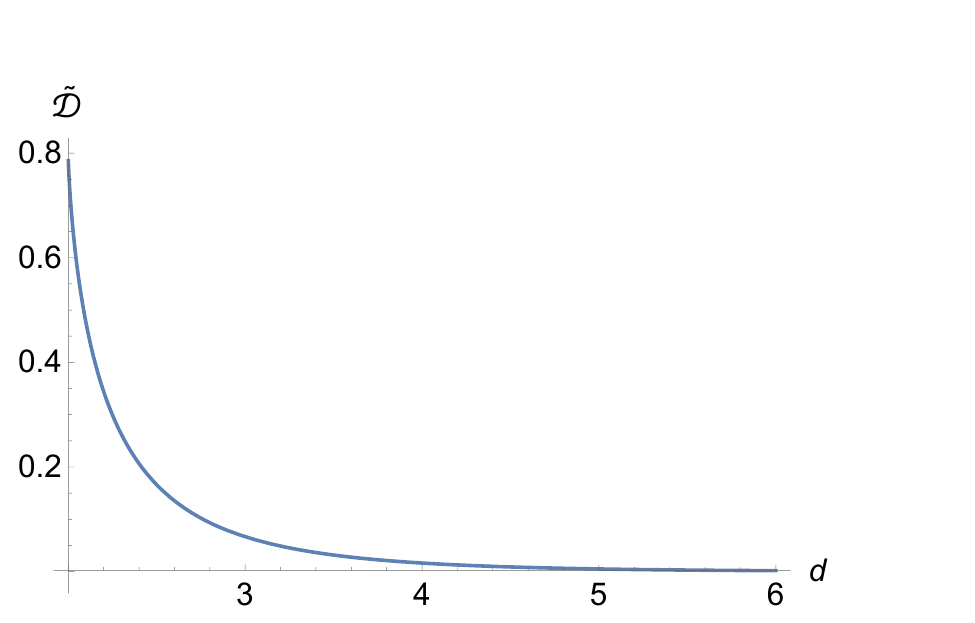
Figure 1. A plot of ˜ D for a single free complex scalar between dimensions 2 < d < 6 when v = 1 / 2